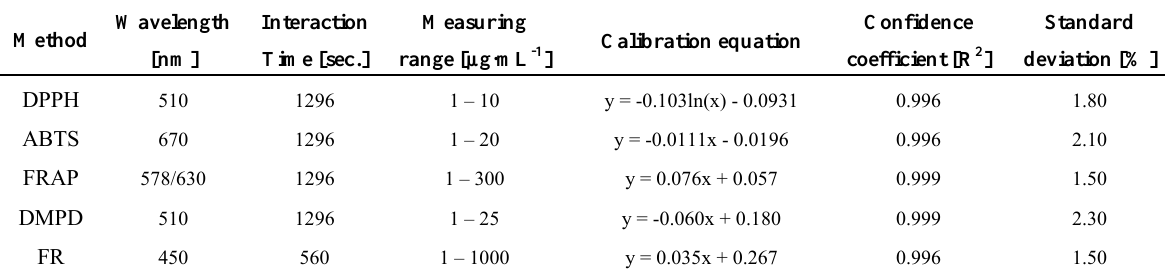
Table 1. Summarization of the parameters for individual methods related to the standard of gallic acid (n = 5).